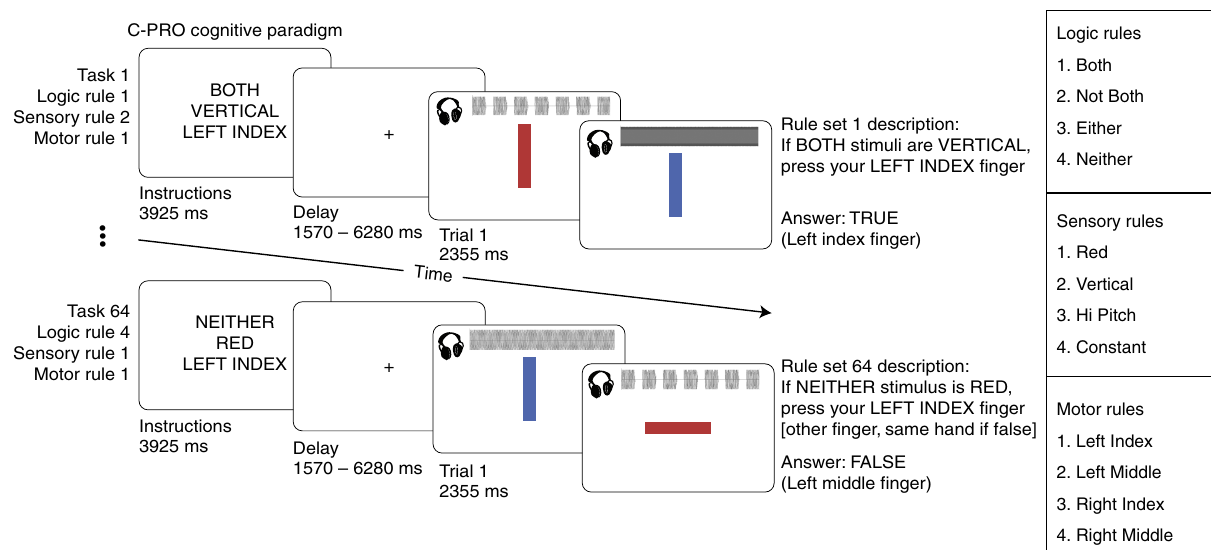
Fig. 2 Concrete Permuted Rule Operations experimental paradigm. For a given task, subjects were presented with an instruction set (i.e., a task-rule set), in which they were presented with three rules each from a different rule domain (logic, sensory, and motor rule domains). Subjects were then asked to apply the presented rule set to two consecutively presented stimulus screens and respond accordingly. Auditory and visual stimuli were presented simultaneously for each stimulus screen. The auditory waveforms are depicted visually but were not presented visually to participants. A mini-block design was used, in which for a given set of instructions three trials were presented consecutively. The inter-trial interval was set to a constant 1570 ms (2 TRs), with a jittered delay following the three trials prior to the subsequent task block (see Methods for more details). Task blocks lasted 28.26 s (36 TRs)